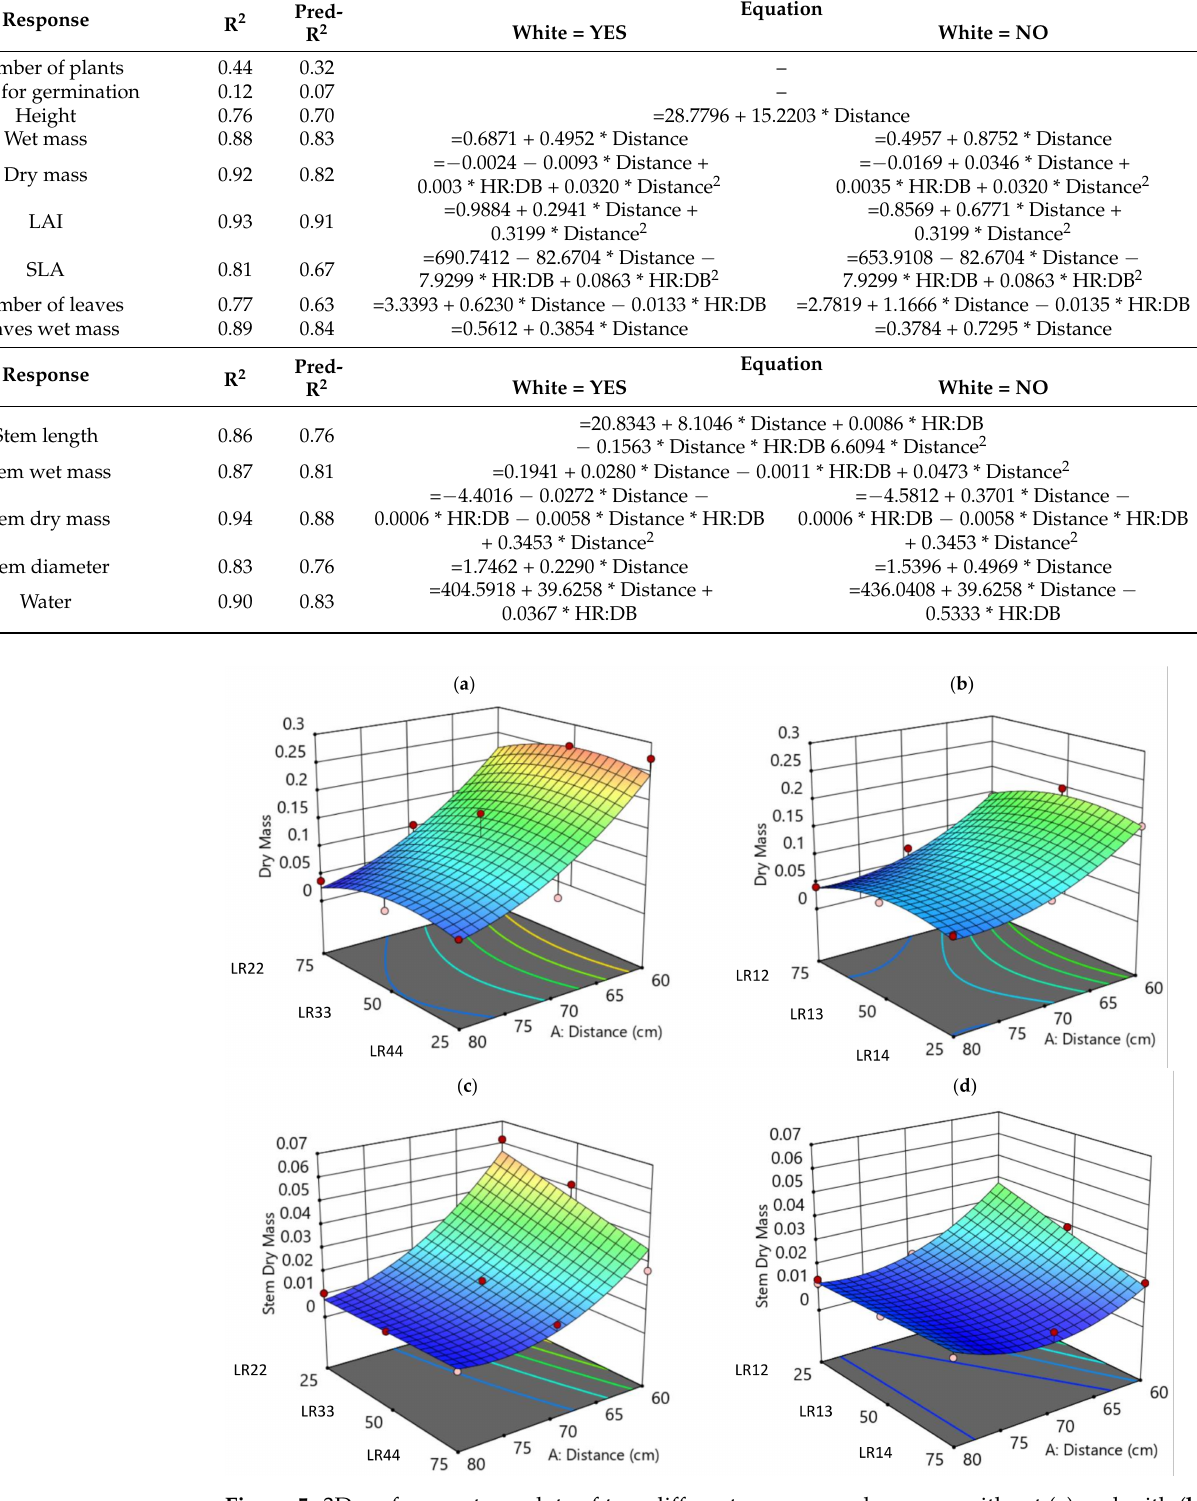
Figure 5. 3D surface contour plots of two different responses: dry mass, without ( a ) and with ( b ) white LEDs; stem dry mass, without ( c ) and with ( d ) White LEDs. Reference to Table 7 for light combination